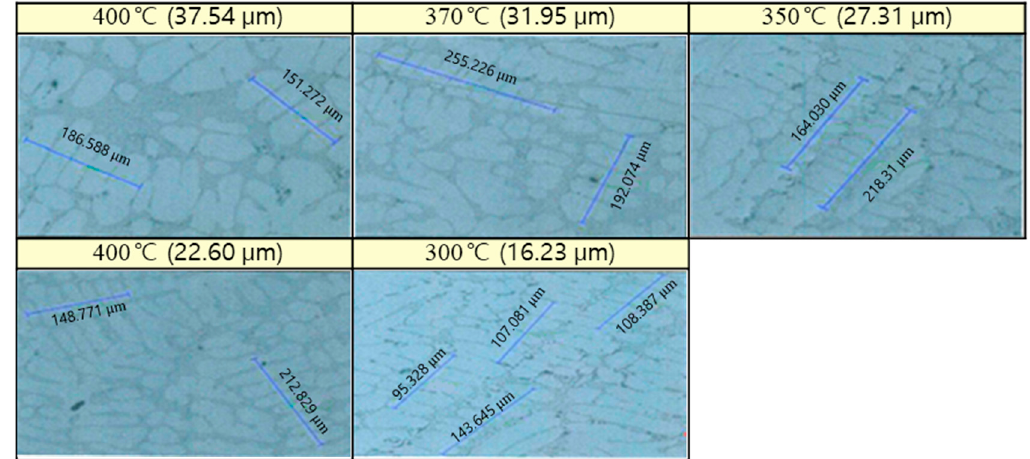
Figure 12. S-DAS measurement results according to mold temperature during the casting process.